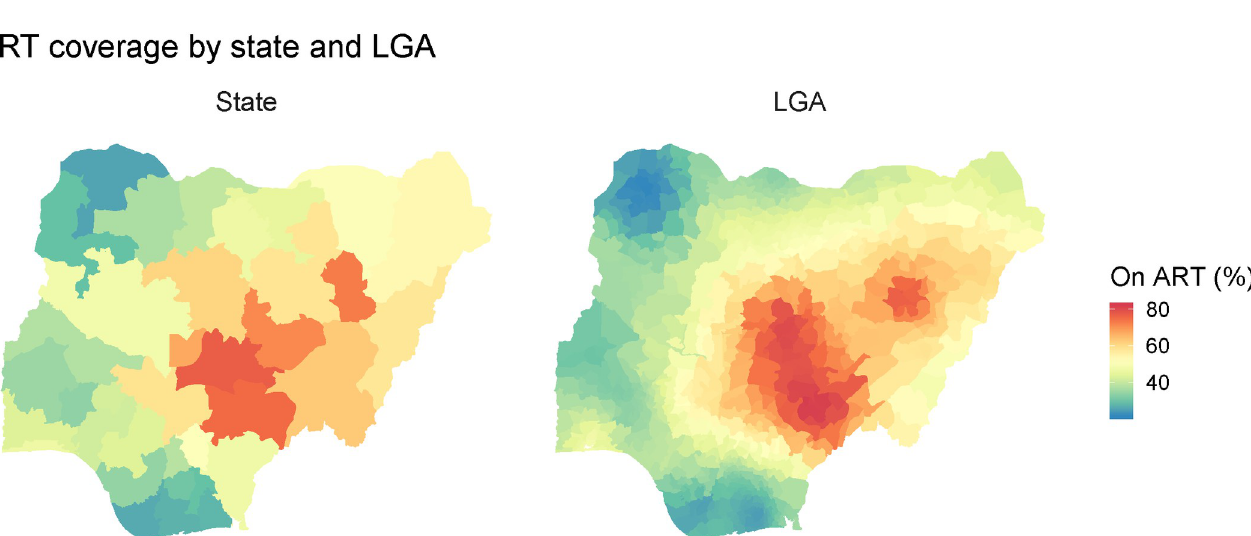
PLOS ONE | https://doi.org/10.1371/journal.pone.0268892 June 8,